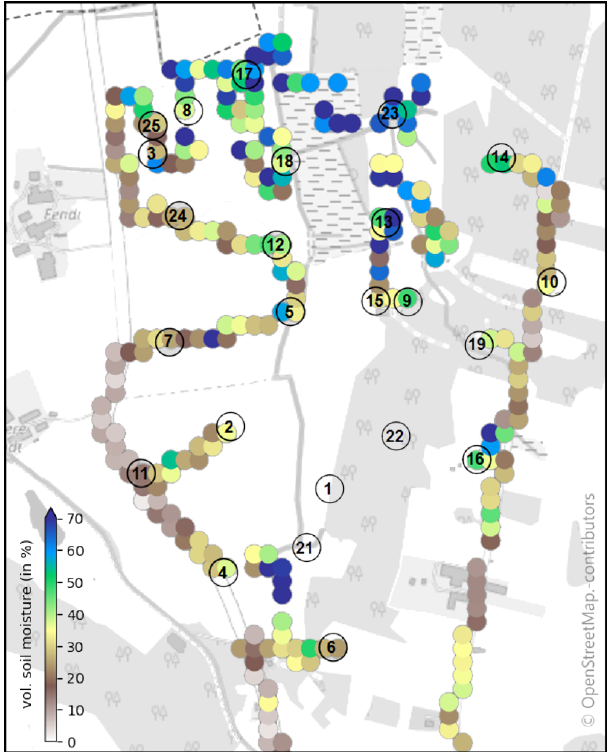
Figure 10. Roving with a hand wagon, passing every stationary sensor except nos. 1, 21, and 22. Basemap © OpenStreetMap con- tributors 2020. Distributed under a Creative Commons BY-SA Li-